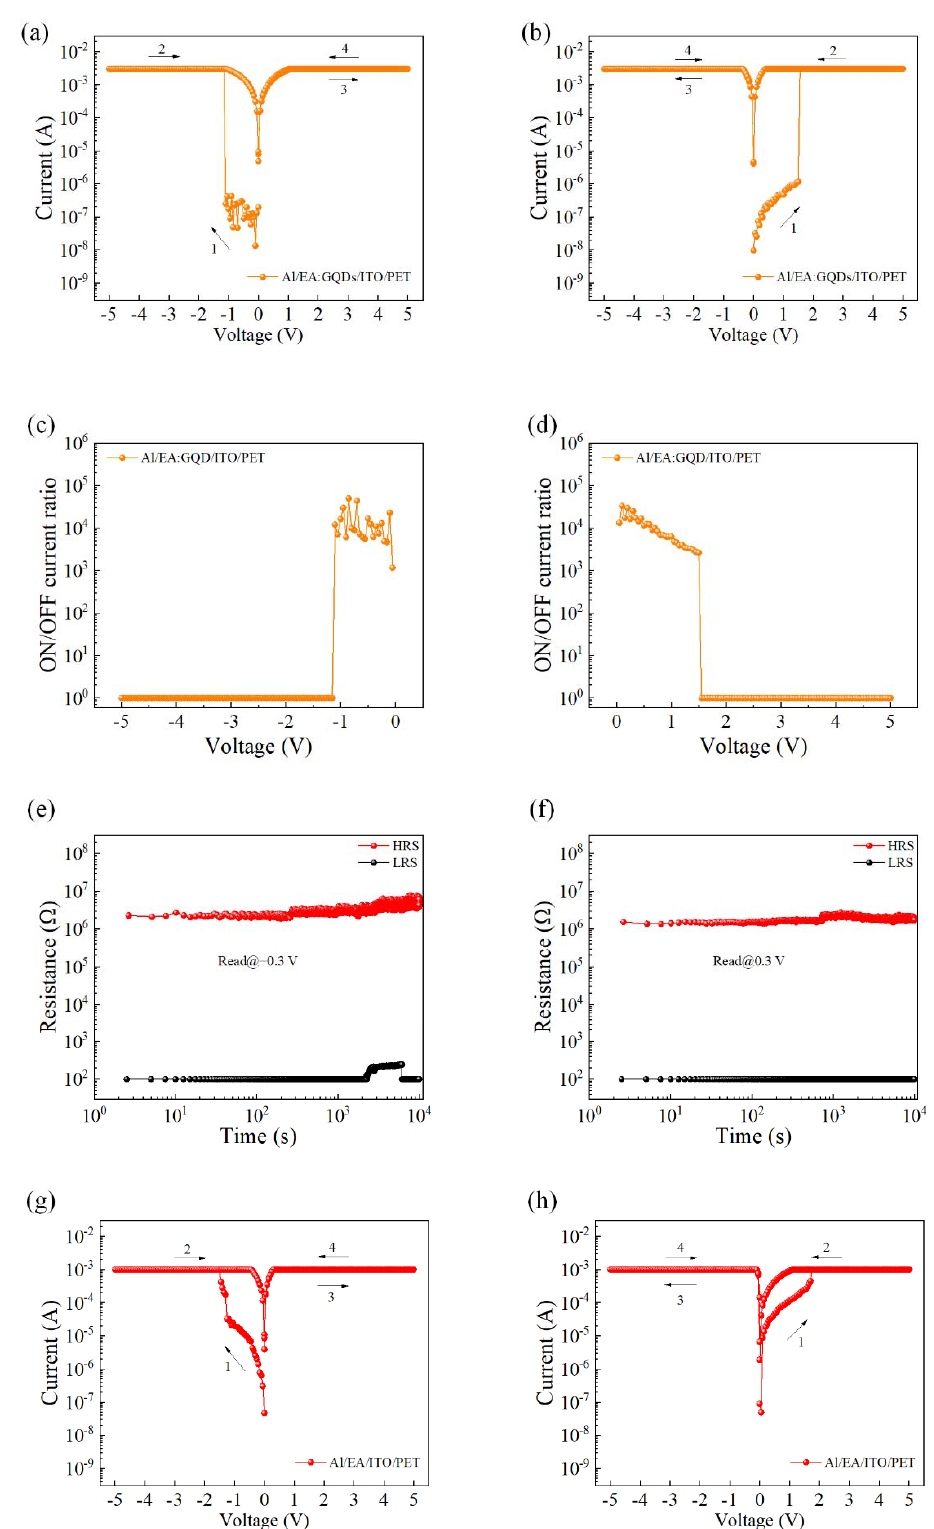
Figure 2. The I–V characteristic curve of the Al/EA:GQD/ITO/PET device: ( a ) initial negative voltage and ( b ) initial positive voltage. Switching current ratio ( c ) initially applied negative voltage and ( d ) initially applied positive voltage. Hold time, read voltage ( e ) − 0.3 V ( f ) 0.3 V. I–V characteristic curve of device Al/EA/ITO/PET. ( g ) Initial negative voltage applied. ( h ) Initial positive voltage applied.